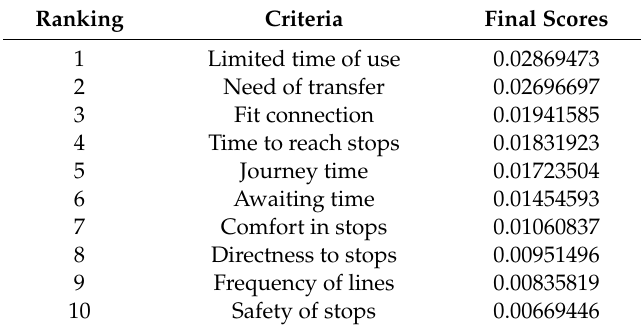
Table 4. Final fuzzy scores of the criteria for Level 3 considering branch